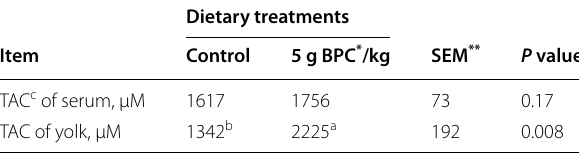
Table 6 Influence of dietary treatments on antioxidant status of laying